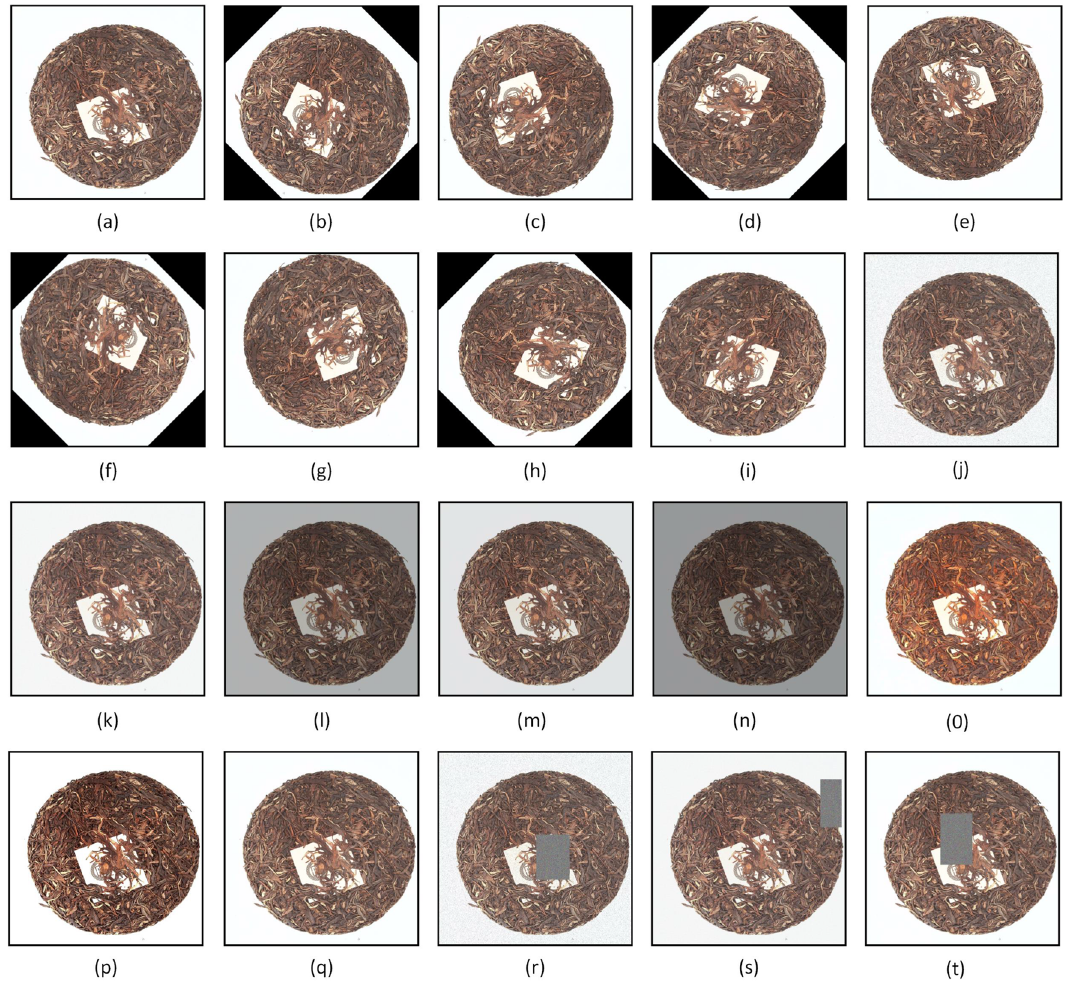
Figure 3. Data enhancement methods, ( a ) original image, ( b ) 45° clockwise rotation, ( c ) 90° clockwise rotation, ( d ) 135° clockwise rotation, ( e ) 180° clockwise rotation, ( f ) 225° clockwise rotation, ( g ) 270° clockwise rotation, ( h ) 315° clockwise rotation, ( i ) mirror flip, ( j ) salt-and-pepper noise, ( k ) Gaussian noise, ( l ), ( m ), ( n ) random brightness adjustment, ( o ), ( p ), ( q ) random adjustment of chroma, contrast and sharpness, ( r ), ( s ), ( t ) random